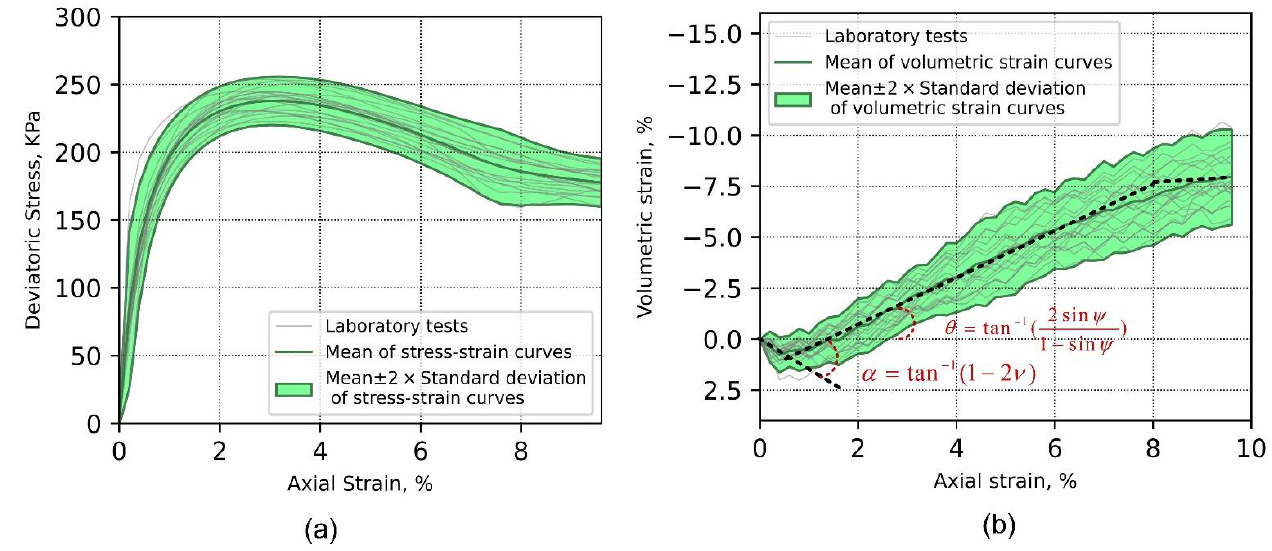
Figure 4. First-order statistics of axial stress–strain curves ( a ) and axial strain–volumetric strain curves ( b ).